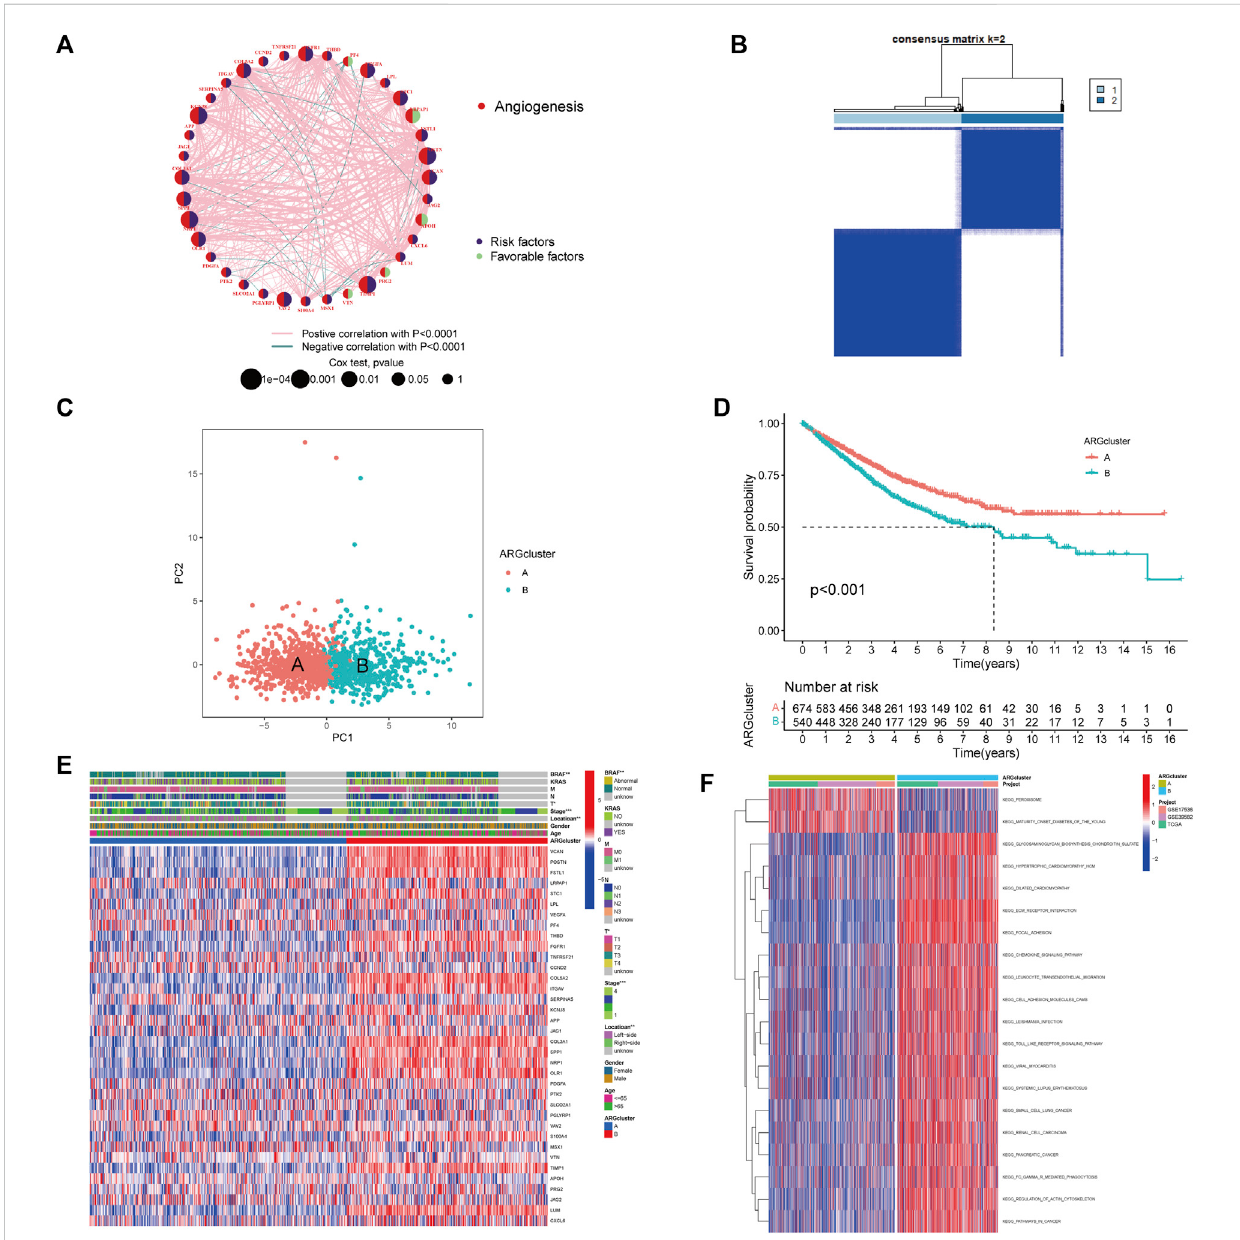
FIGURE 2 Identi fi cationofangiogenesissubtypesandrelevantbiologicalpathways. (A) TheInteractionnetworkbetweenARGsinCRC.Thecirclesrepresented thedifferentARGsandthecirclesizerepresentedtheeffectofeachgeneonprognosis, withvaluesrangingfrom p < 0.0001, p < 0.001, p < 0.01, p < 0.05, and p < 1, respectively, by the Log-rank test. purple in the circle, prognostic risk factors; green in the circle, prognostic protective factors. The lines connecting genes indicated their interactions, and the thickness indicated the strength of the association between regulators. Pink color indicated positive association, green color indicated negative association. (B) Heatmap of consensus matrix de fi ning two clusters. (C) The PCA analysis revealed signi fi cant differences between subtypes. (D) Kaplan-Meier curves of OS for CRC patients in the cohort (Log-rank test, p < 0.001). (E) Differences in clinicopathological characteristics and expression levels of ARGs in two subtypes. (F) Differences in biological pathways among subtypes as determined by the